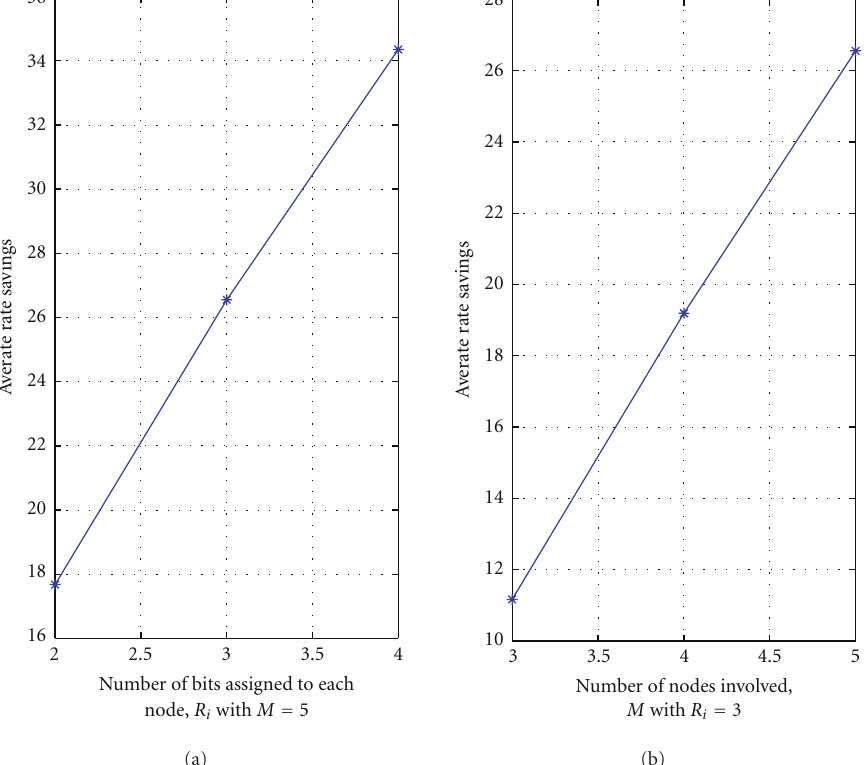
Figure 6: Average rate savings achieved by the distributed encoding algorithm (global merging algorithm) versus number of bits, R i with M = 5 (left) and number of nodes with R i = 3